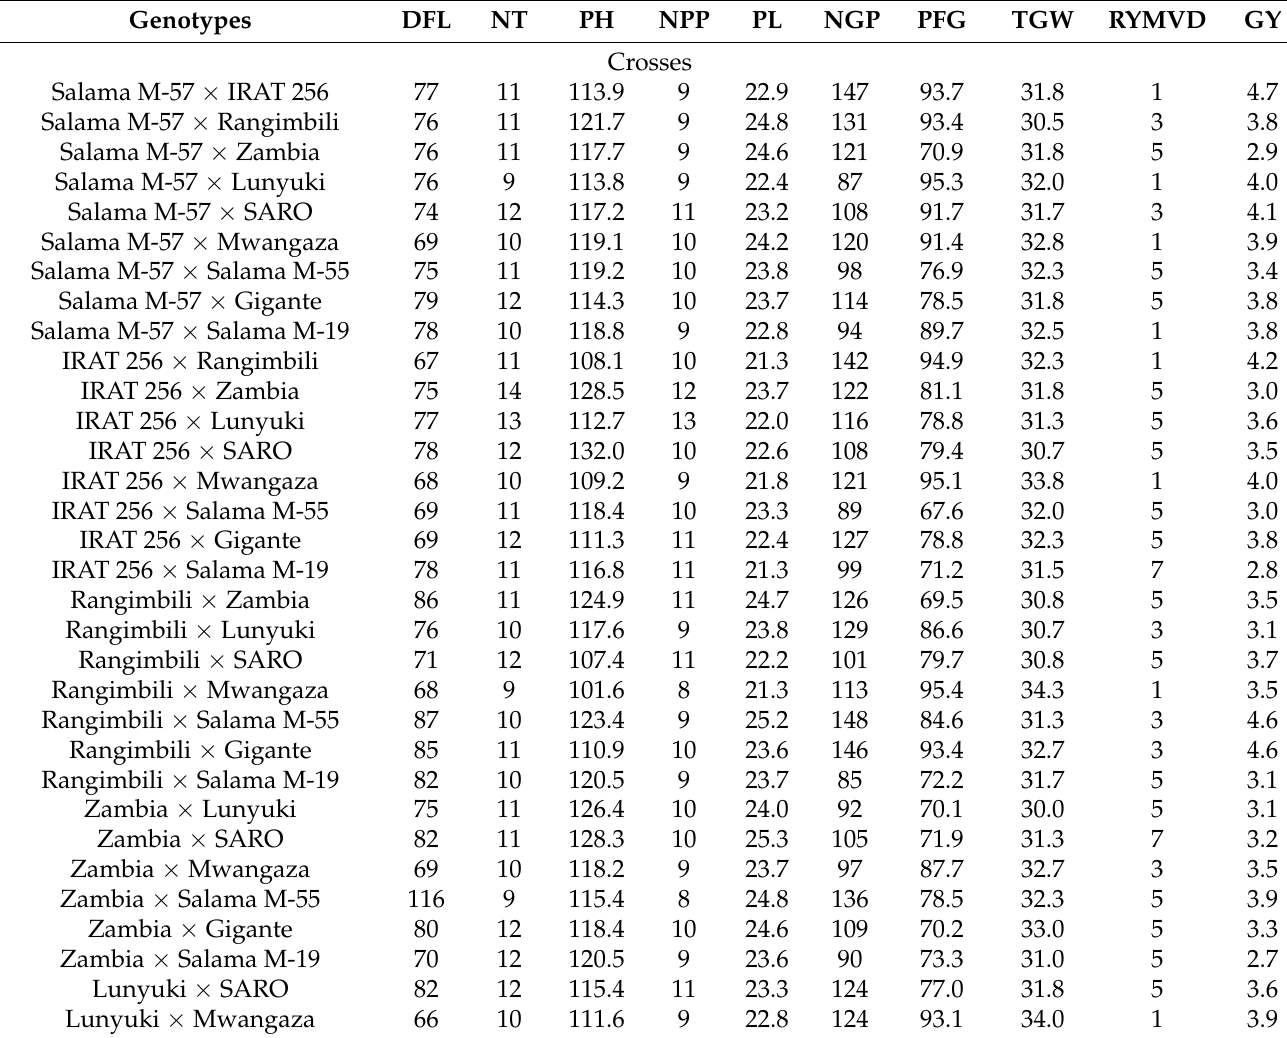
Table 5. Means for agronomic traits and RYMVD reaction of 10 parental genotypes and 45 F2 crosses of rice evaluated across locations in